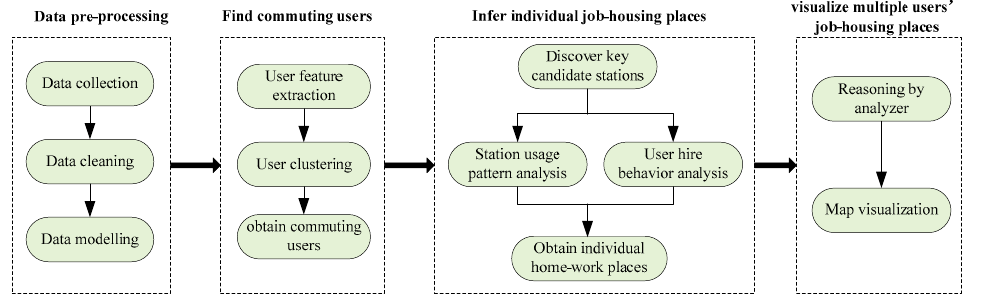
Figure 3. The system pipeline.